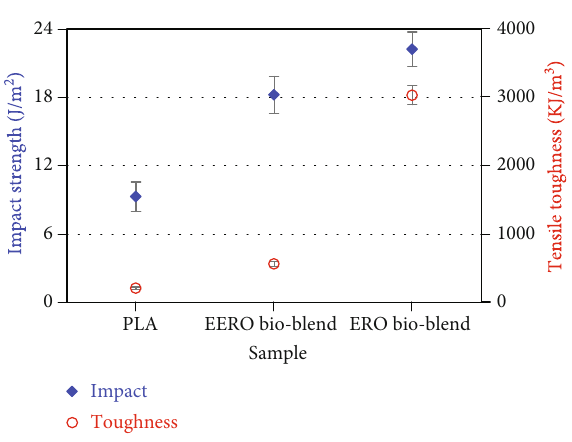
Figure 3: The e ff ect of plasticizers on impact strength and tensile